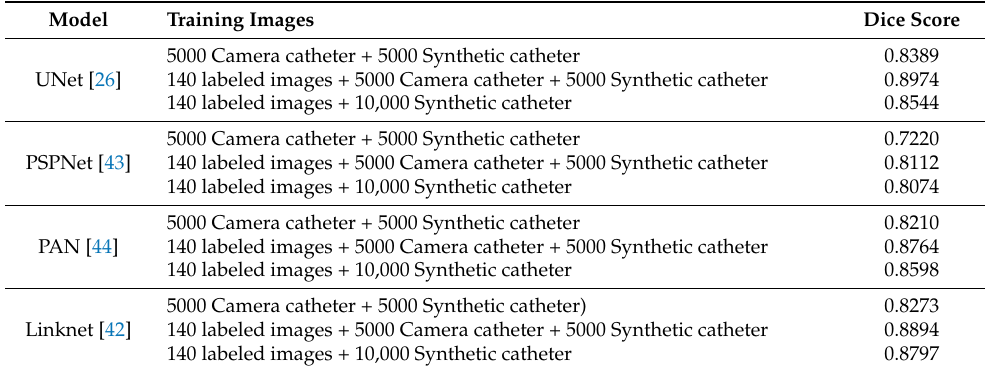
Table 2. Comparison of segmentation models using camera and synthetic catheters including labeled images. All the models are evaluated on real catheter X-Ray test set.